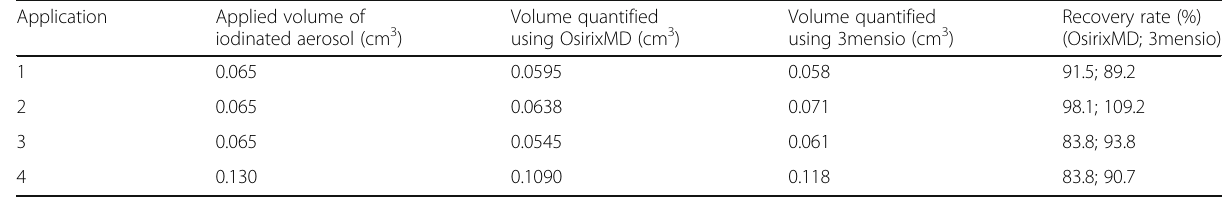
Table 2 Overview of the volumetric quantification and recovery rates of the nasal droplet depositions after nasal application of an iodinated contrast agent solution with 92.5 mgI/mL using a single-dose nasal spray device Application